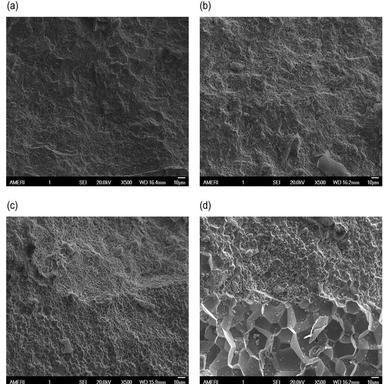
SEM of interface of TY-6-1. (a)Interface of Layer1-Layer2, (b)Interface of Layer2-Layer3, (c)Interface of Layer3-Layer4, (d)Interface of Layer4-Layer5.